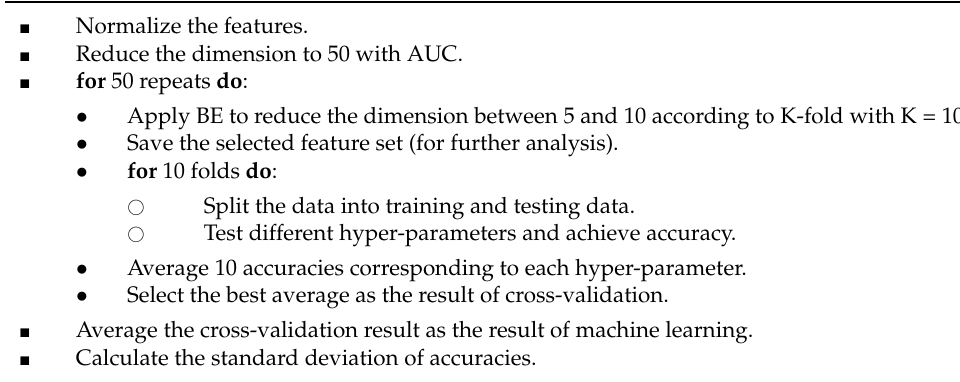
Table 1. Pseudo-code of the machine learning